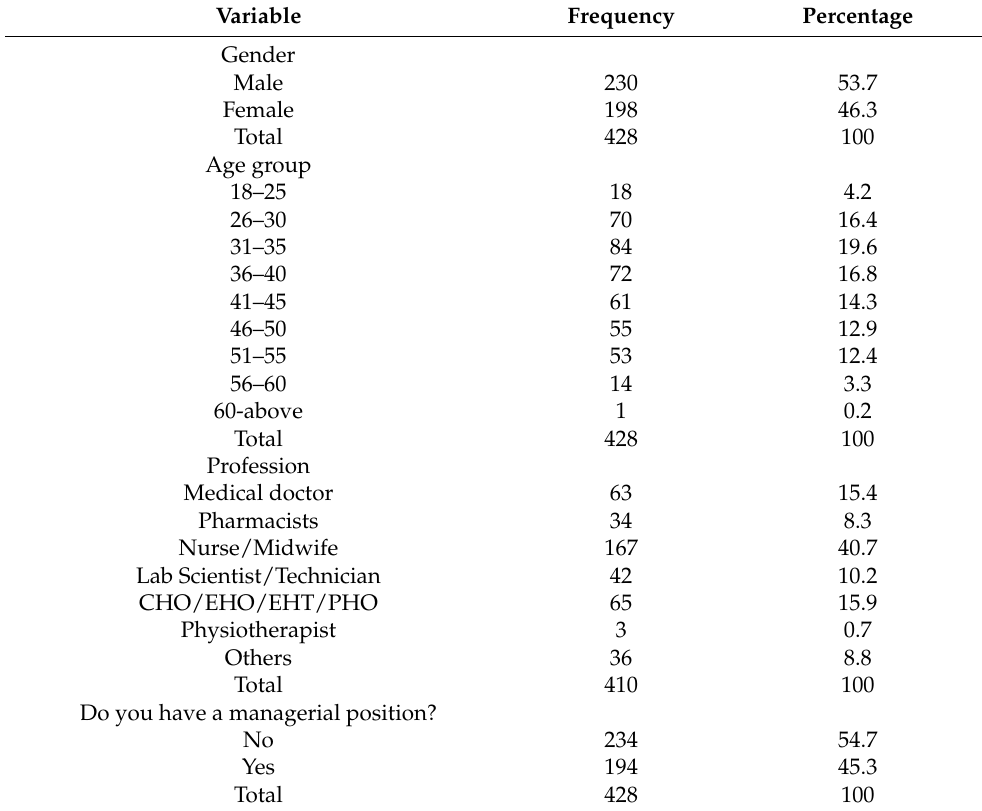
Table 2. Description of participants’ socio-demographic characteristics ( n =